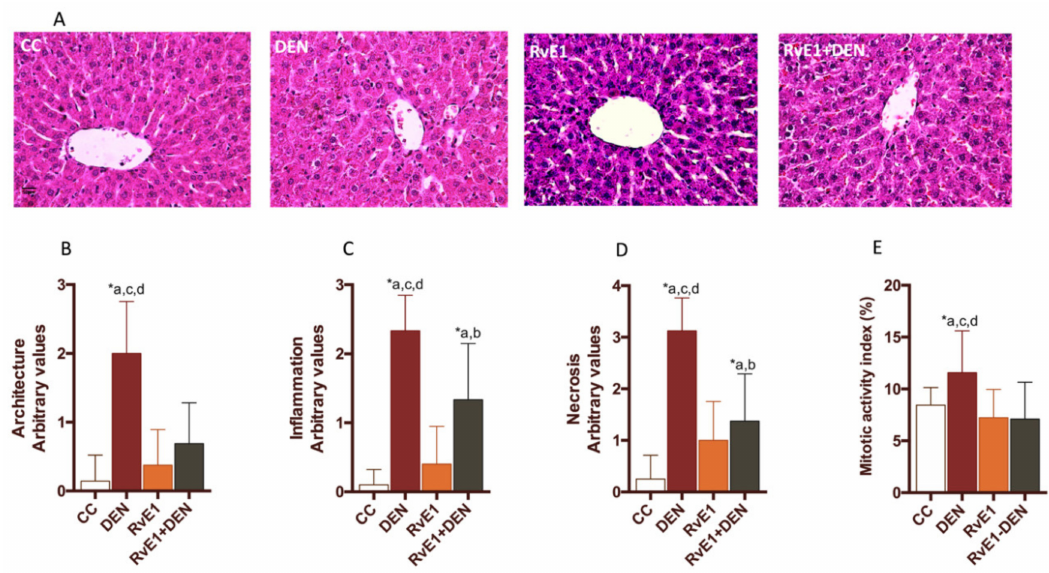
Figure 1. E ff ect of RvE1 on liver morphology. ( A ) Representative liver sections stained with hematoxylin-eosin. Scores of livers sections were graphed for ( B ) architecture, ( C ) inflammation, ( D ) necrosis and ( E ) mitotic activity index (MAI) measured as a percentage of a whole section. At least 20 fields for every sample were analyzed at 400 × magnification. n = 6 to 9 animals per experimental group. Asterisk indicates p < 0.05, and the letters identify the experiments that are compared and present this statistical di ff erence. a = control; b = DEN; c = RvE1 and d = RvE1 +